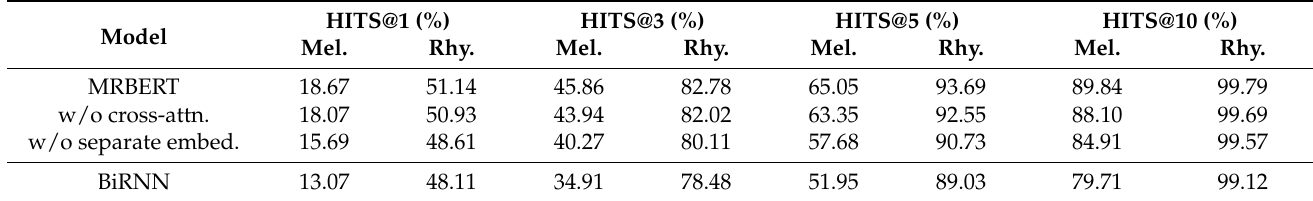
Table 5. Ablation experimental results of the conditional generation